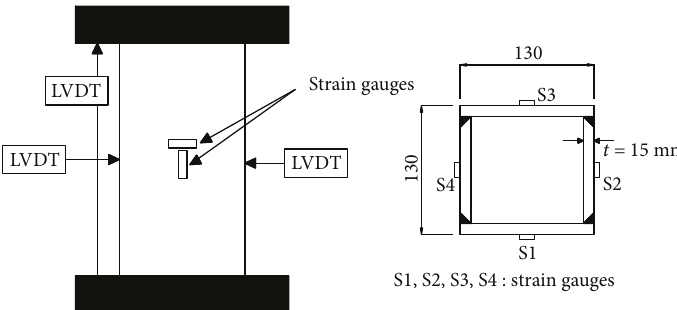
Figure 5: Measurement plan.